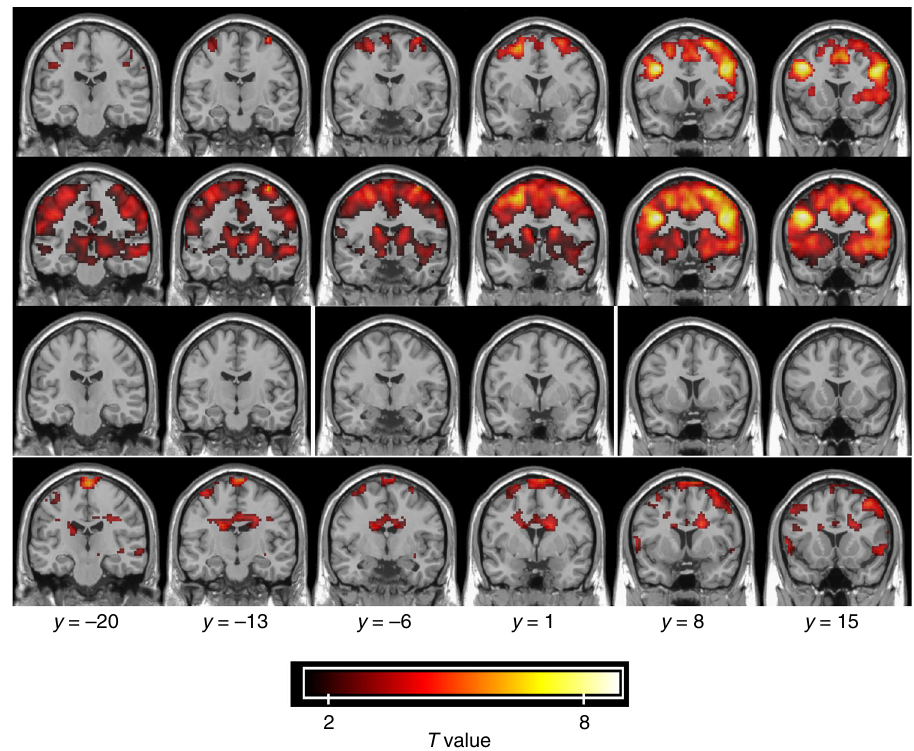
Fig. 8 GM and WM activations detected using GM and WM HRFs. The fi rst and second rows show the activation map based on canonical HRF model embedded in SPM ( fi rst row, P < 0.05, two sample t -test, FWE corrected; second row, P < 0.02, two sample t -test, uncorrected). The third row and fourth row show the activation map based on a custom regressor reconstructed by convolving incongruent stimuli with the fi tted HRF for the tract Fron_L to Fron_R (third row, P < 0.05, t -test, FWE corrected; fourth row, P < 0.02, t -test, uncorrected)